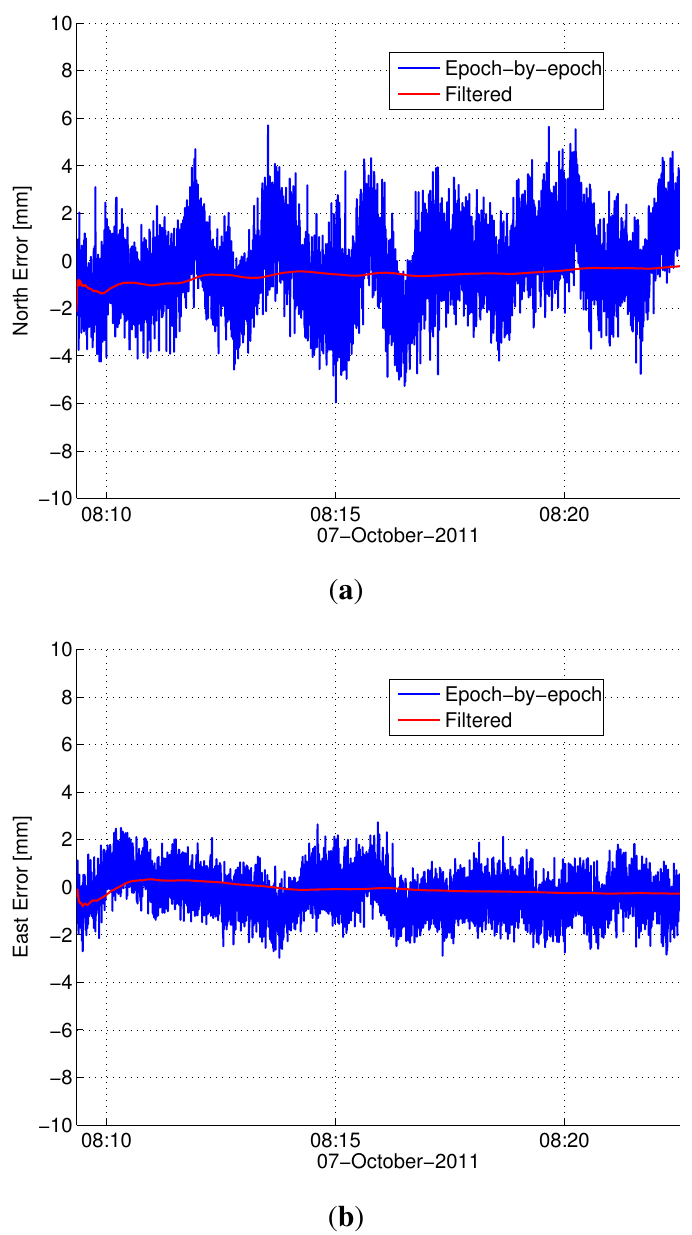
Figure 7. Estimation error (mm) for kinematic data (20-m baseline) using the proposed method: Rotation 1. ( a ) North error; and ( b ) east